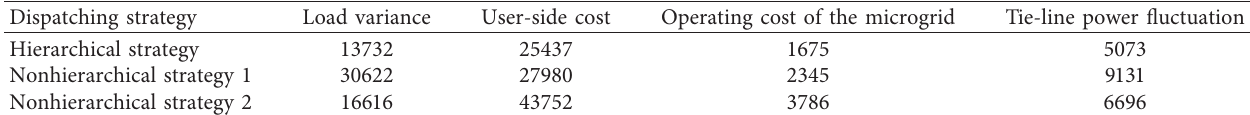
Table 4: Comparison of operation results of three dispatching